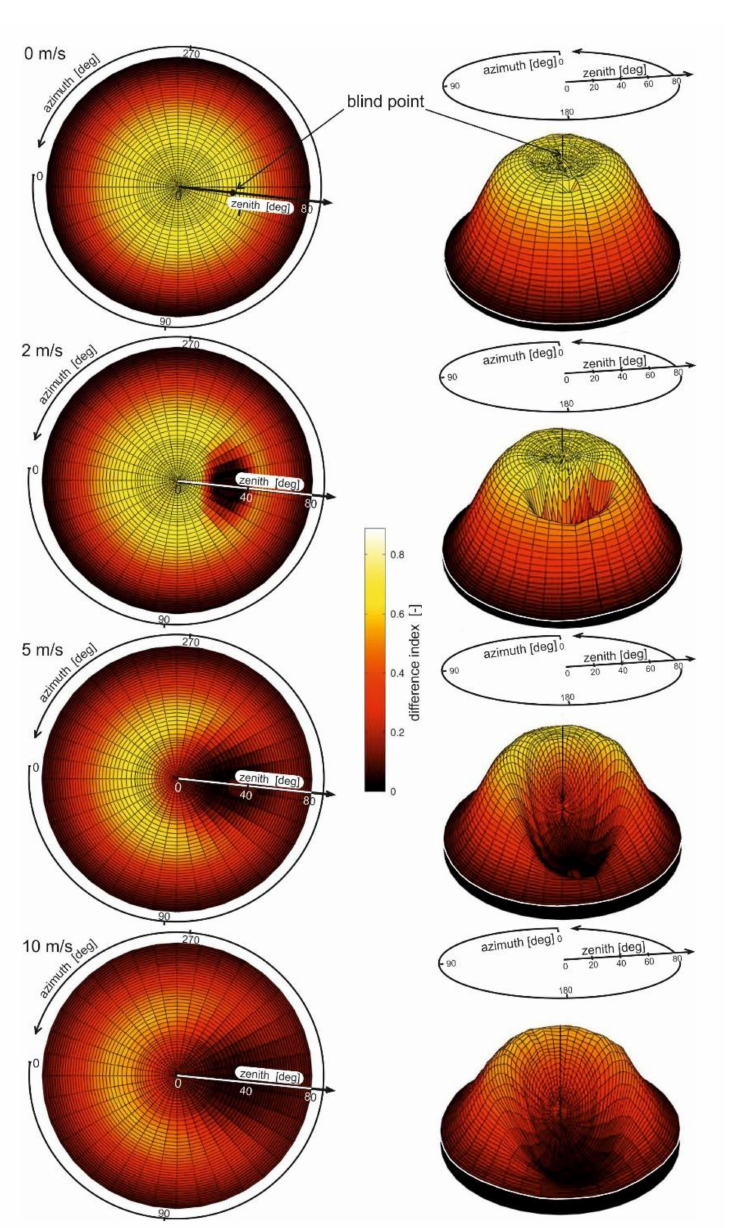
Figure 6. Difference indices as described in Figure 5, but for Romashkino-type